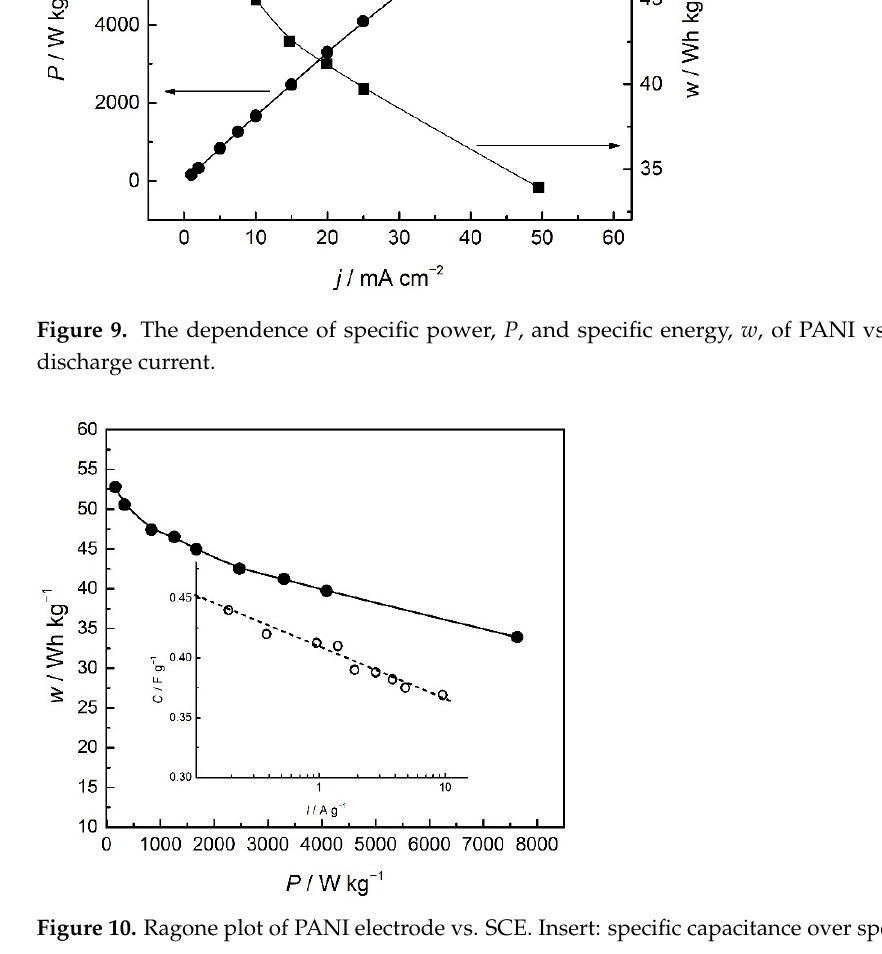
Figure 10. Ragone plot of PANI electrode vs. SCE. Insert: specific capacitance over specific current.